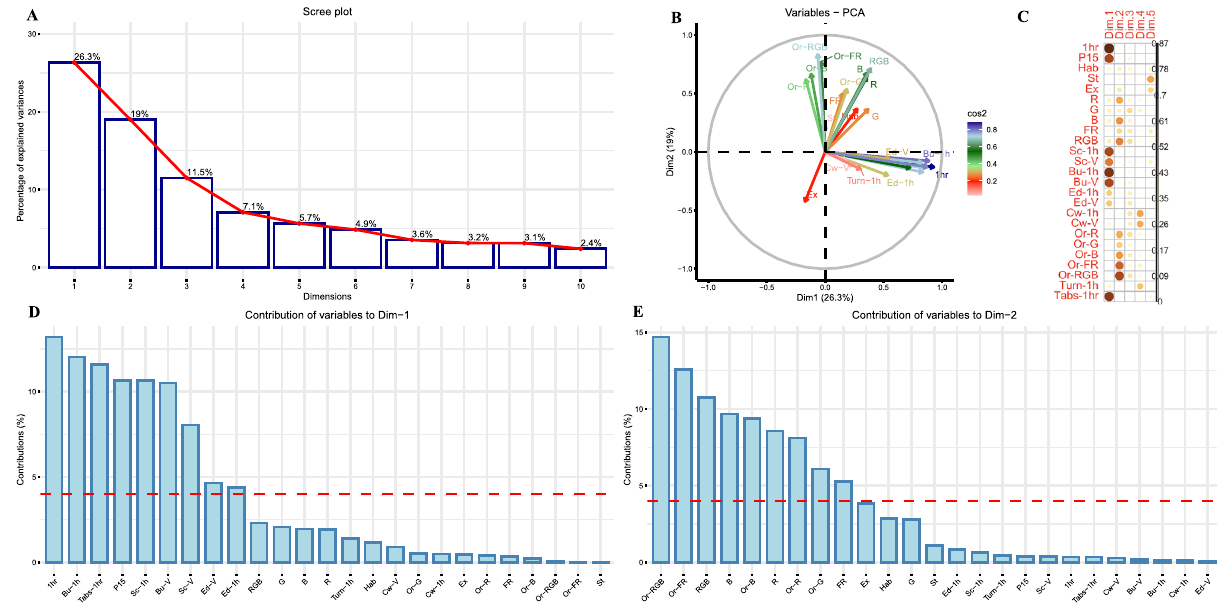
Figure 3. Principal components analysis: the principal component analysis of the dataset identified 22 principal dimensions explaining 100 percent of the variation in the dataset. The scree plot ( A ) shows 10 principal dimensions accounting for 86.74% of the variance. To analyze the contribution of each variable towards the variation in our dataset, we used principal component 1 (Dim1) which explained 26.3% variation, and principal component 2 (Dim2) explaining 19% of the variation ( B ). The correlation plot ( C ) shows the correlation of each variable for the first 5 dimensions of the principal components. The major contributors for Dimension1 ( D ) were the activity-related variables, while Dimension 2 was greatly influenced by the orientation variables ( E